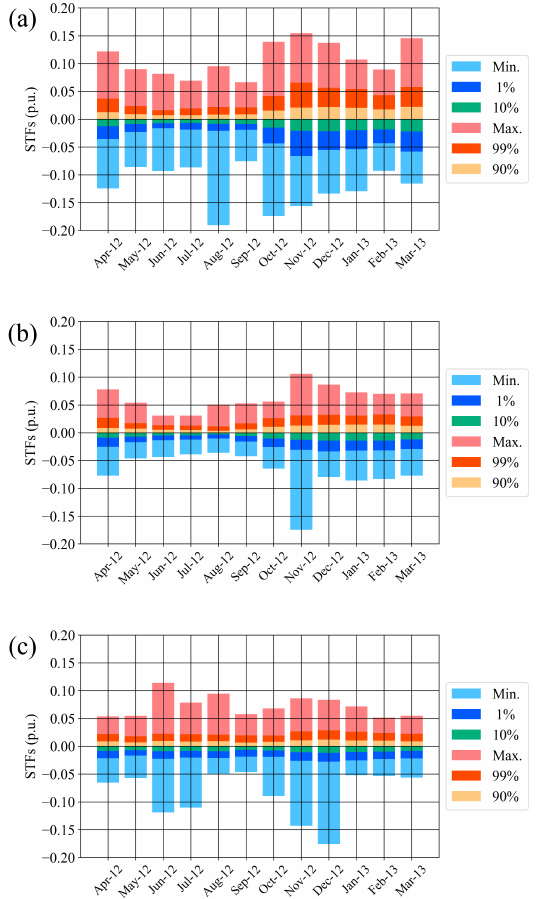
Figure 10. The maximum, minimum, and percentiles of short-term fluctuations (STFs) in each month in the ( a ) Hokkaido, ( b ) Tohoku, and ( c ) Kyushu areas in the 2012 fiscal year. In the Hokkaido and Tohoku areas, the percentiles have larger amplitudes in winter, from November to February. The percentiles for the Kyushu area are approximately